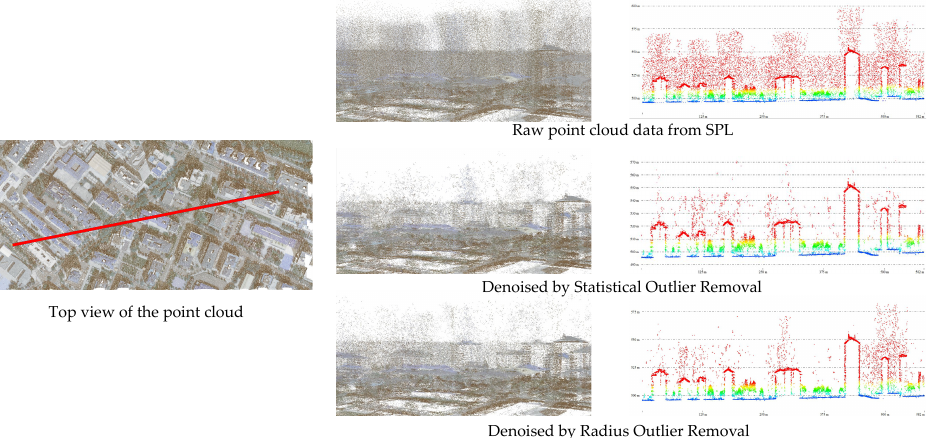
Figure 1. The raw point clouds data from SPL and the denoising results using existing algorithms. The three images in the right hand show the profile line in the area of the red line on the